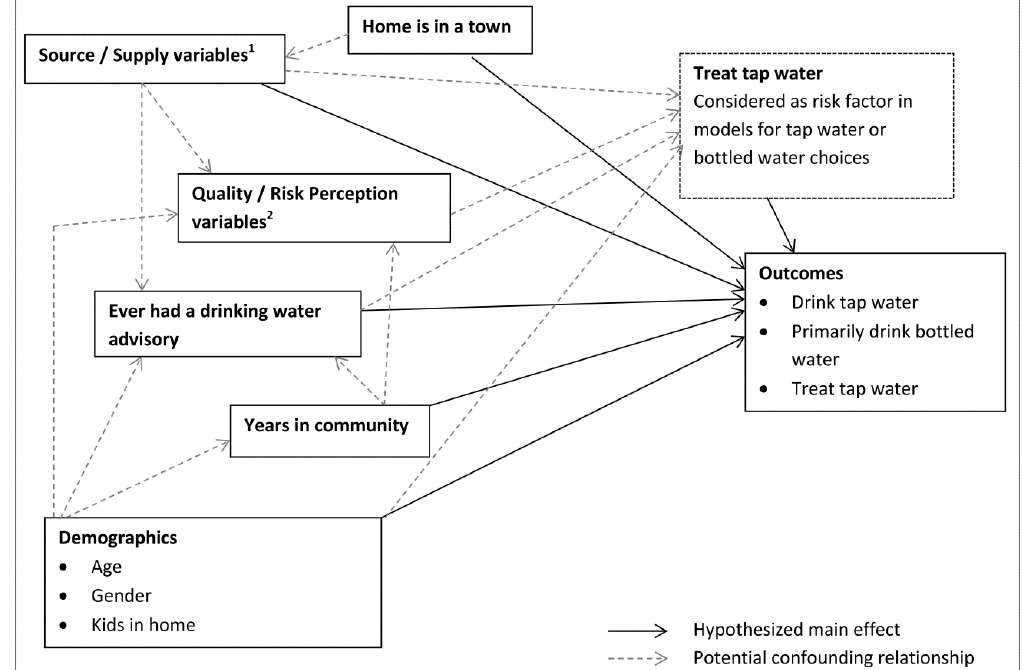
Figure 1. Generalized causal diagram used to direct model development for each of the outcomes related to water consumption and treatment choices (potential interactions not diagrammed for